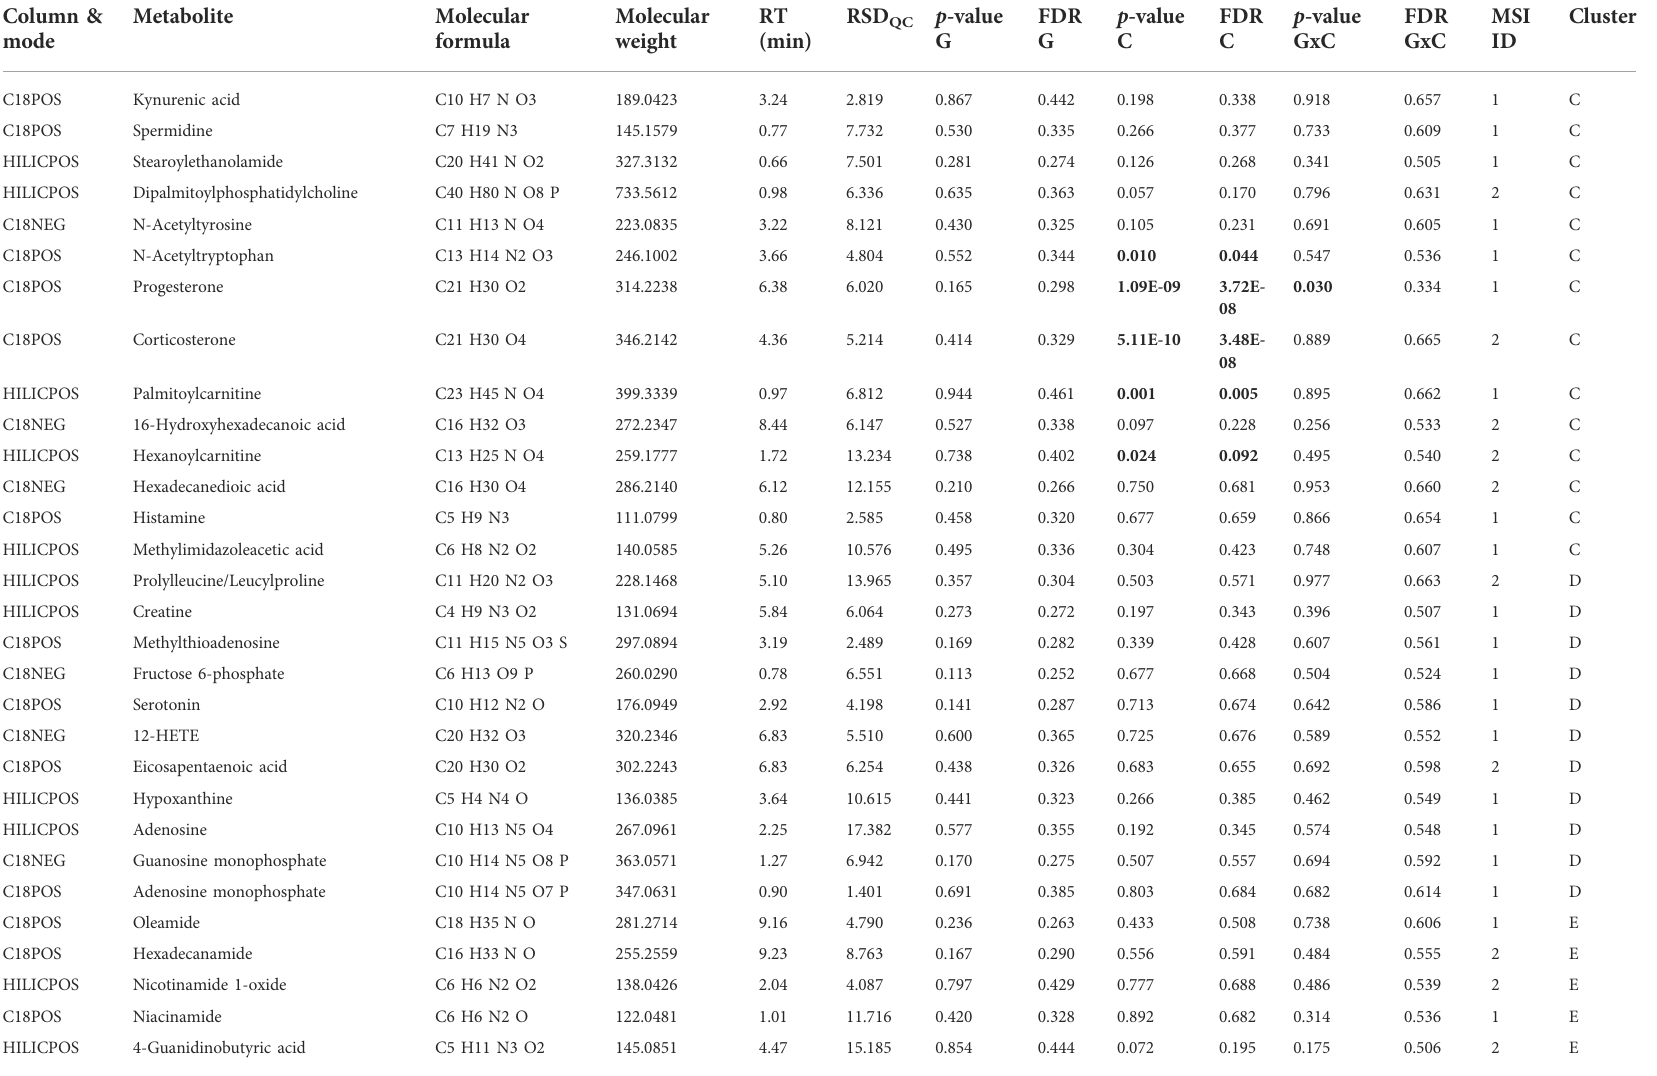
TABLE 1 ( Continued ) Summary of the metabolites identi fi ed/annotated from WT and DKI mouse plasma. A total of 83 plasma metabolites were identi fi ed/annotated, including 17 metabolites signi fi cantly changed by condition (i.e., exercise versus rest) and one metabolite signi fi cantly changed by genotype (i.e., DKI versus WT) based on univariate analysis. Statistically signi fi cant values ( p < 0.05